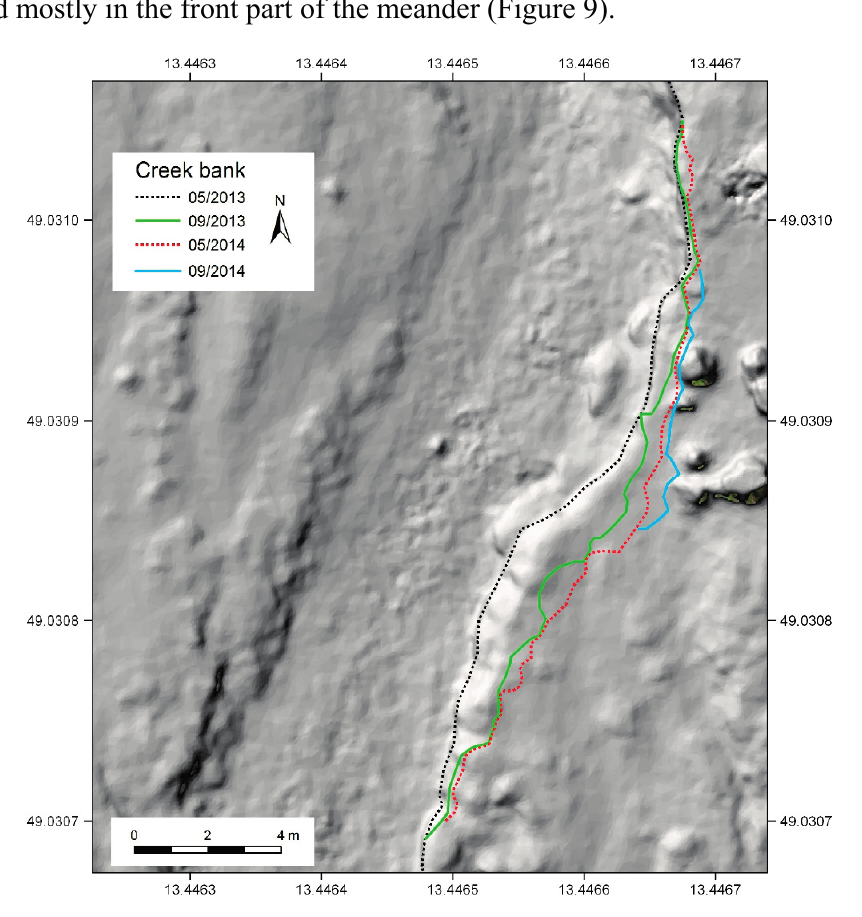
Figure 9. Evolution of lateral erosion at the most active zone in the segment